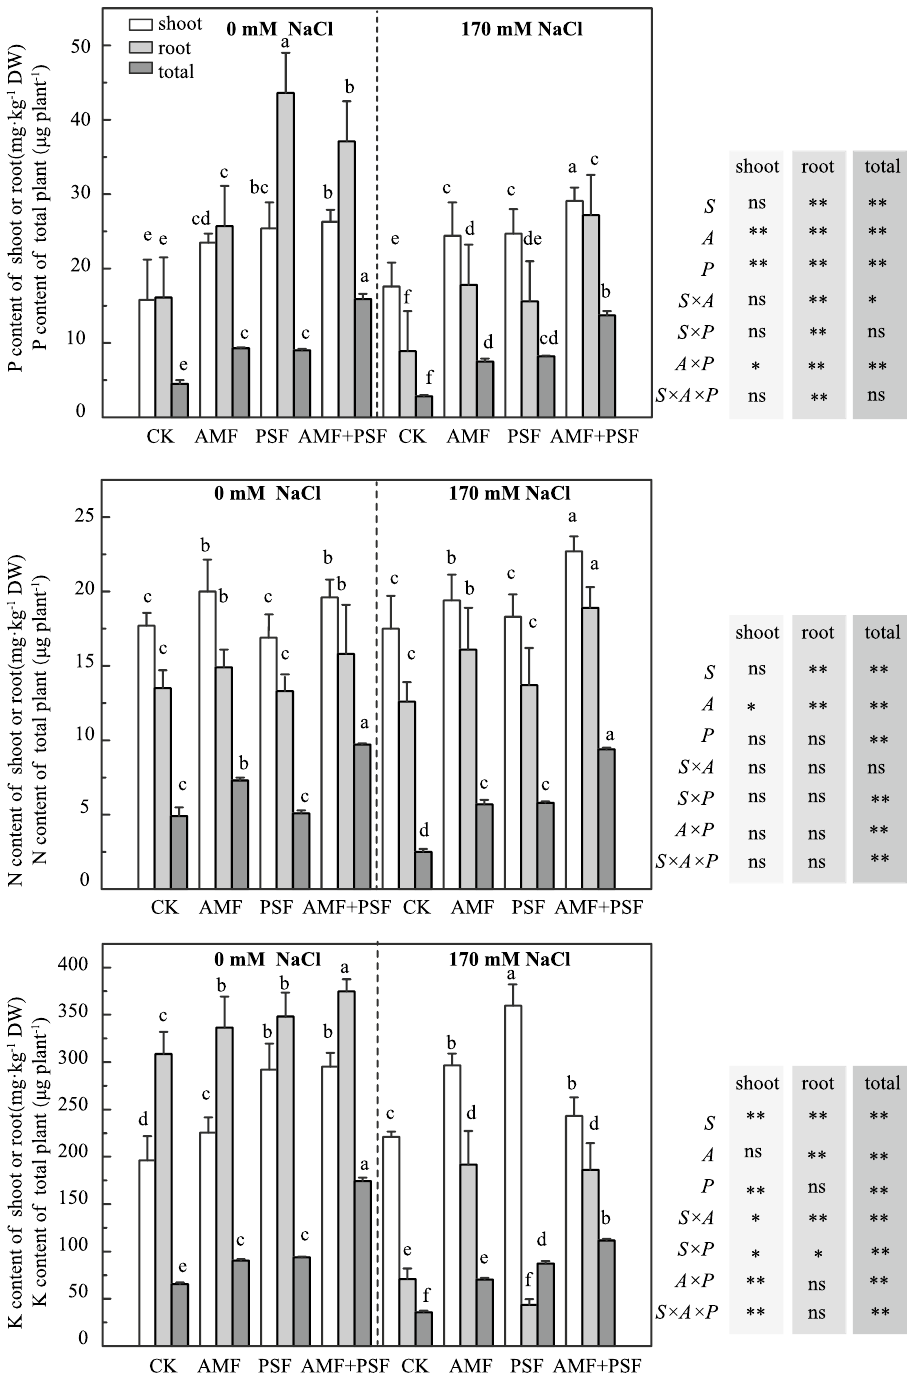
Figure 1. Effects of F. mosseae and/or A. spartima on the N, P, and K contents of beach plum under saline and non-saline conditions. The values of each parameter labeled by different letters indicate significant